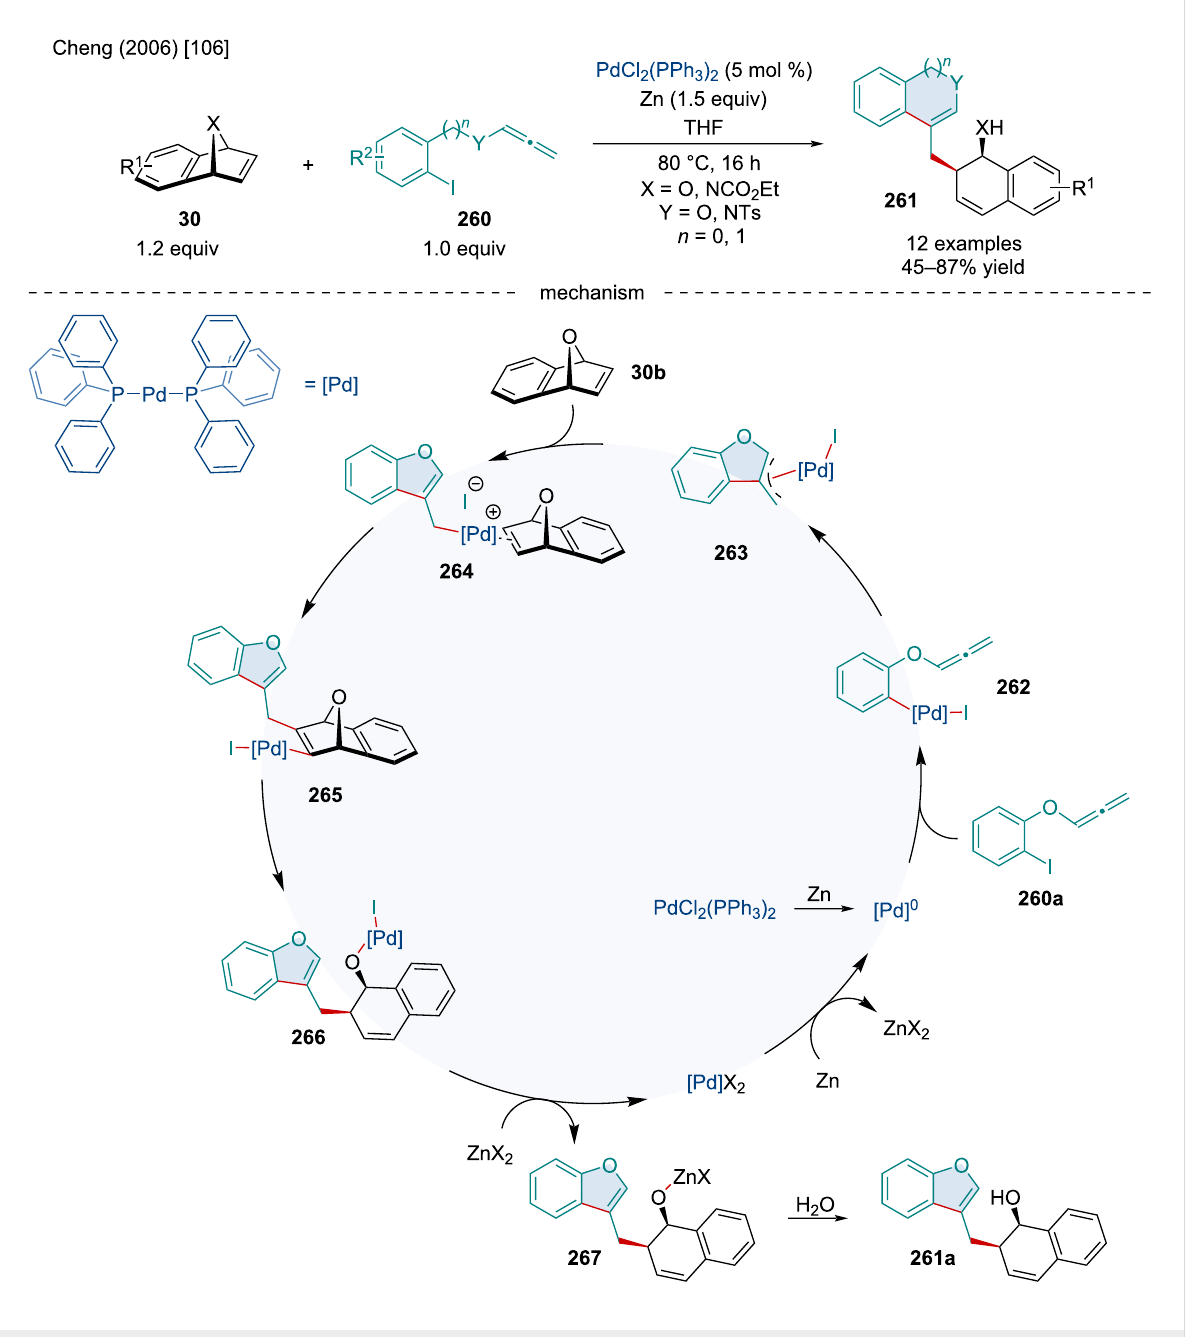
Scheme 50: Pd-catalyzed intramolecular cyclization/ring-opening reaction of heterobicyclic alkenes 30 with 2-iodophenoxyallenes 260